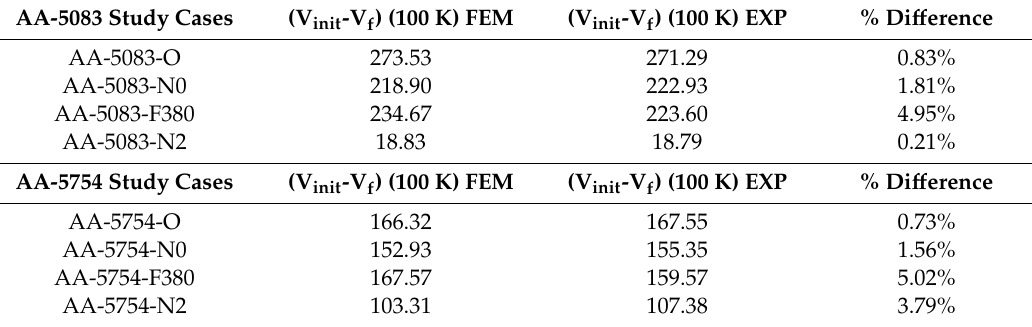
Table 3. Wear in terms of volume loss (mm 3 ) for FEM simulations and experimental tests at 100,000